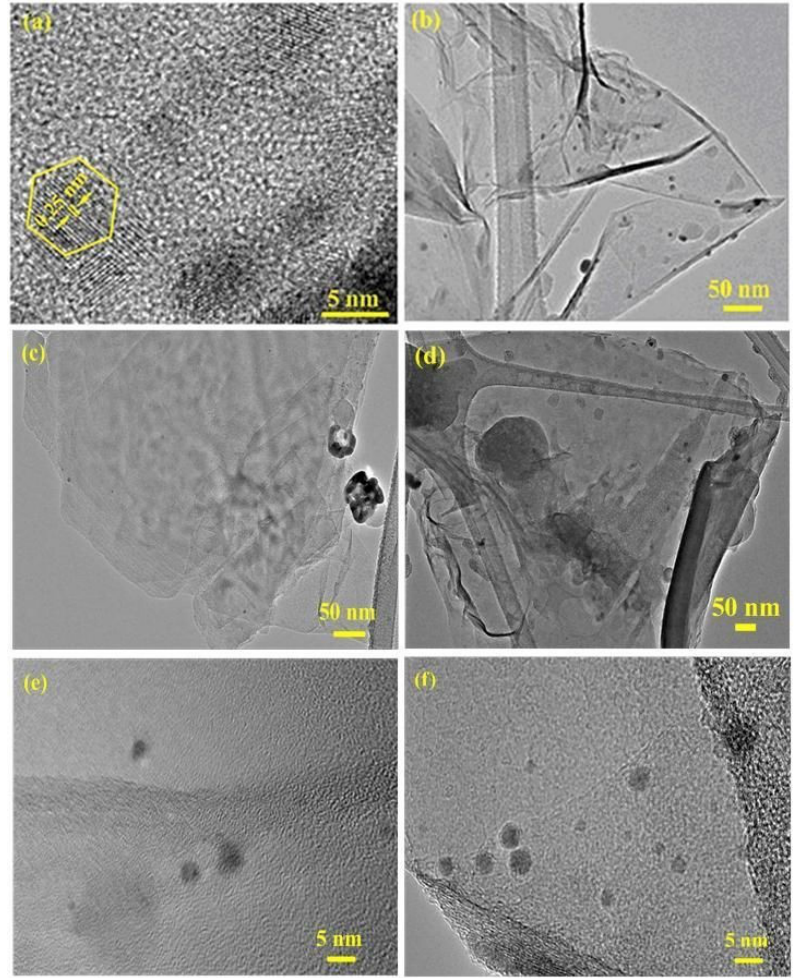
Figure 6. HR-TEM images of ( a ) AgNPs, ( b ) RGO/AgNPs, ( c , e ) RGO/AgNPs-(PS-PMMA), and ( d , f ) R-(GO-(PS-PMMA)-AgNPs.